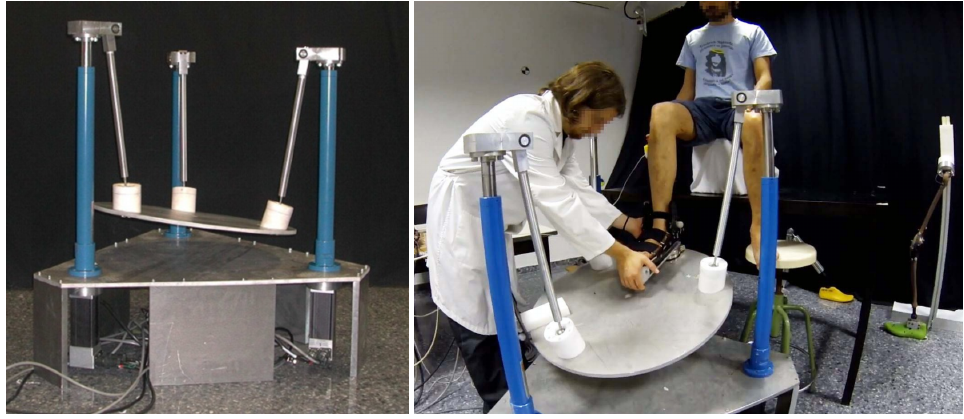
Figure 7. Left : a snapshot showing our 3-PRS robot. Right : a physiotherapist is fitting the patient’s foot in the orthopedic